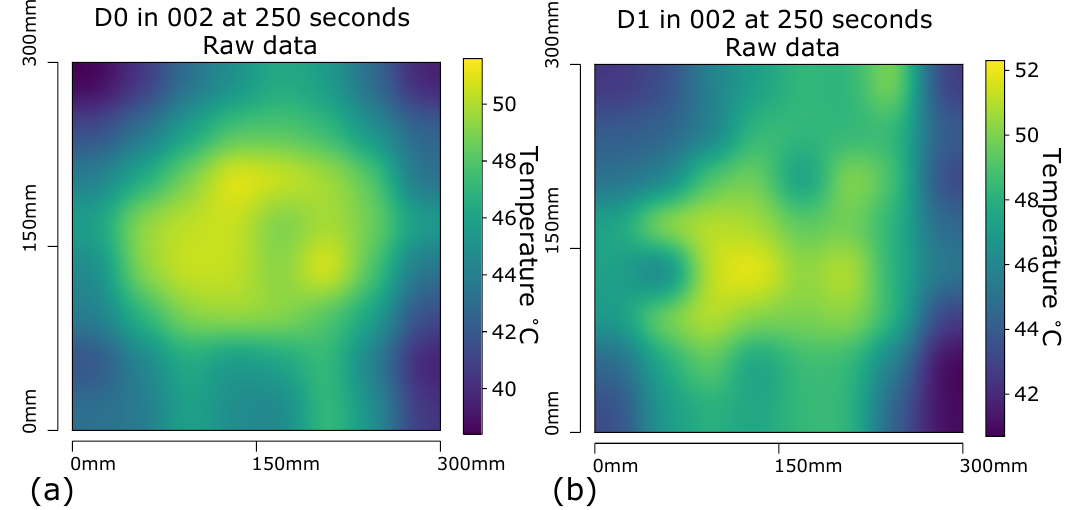
Figure 7. ( a ) Panel D0 at 250 s with Gaussian interpolation applied to RTD array captured data ( b ) Panel D1 at 250 s with Gaussian interpolation applied to RTD array captured